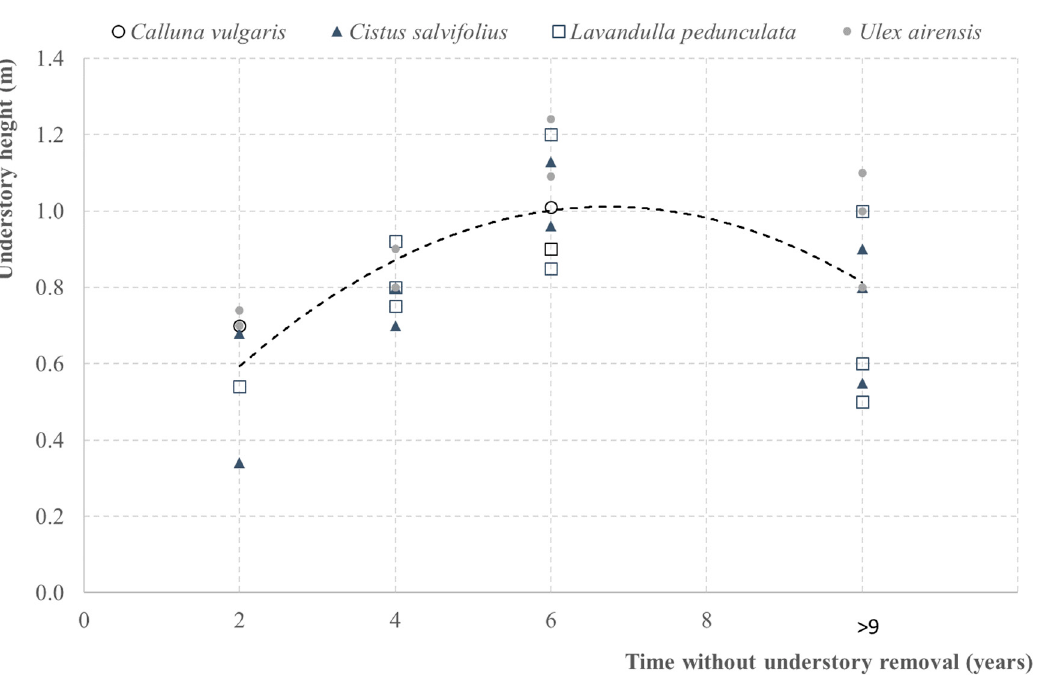
Figure 2. Total height evolution for the main understory shrub species present in the stands trial. The trend line shows the evolution of the total mean height value.